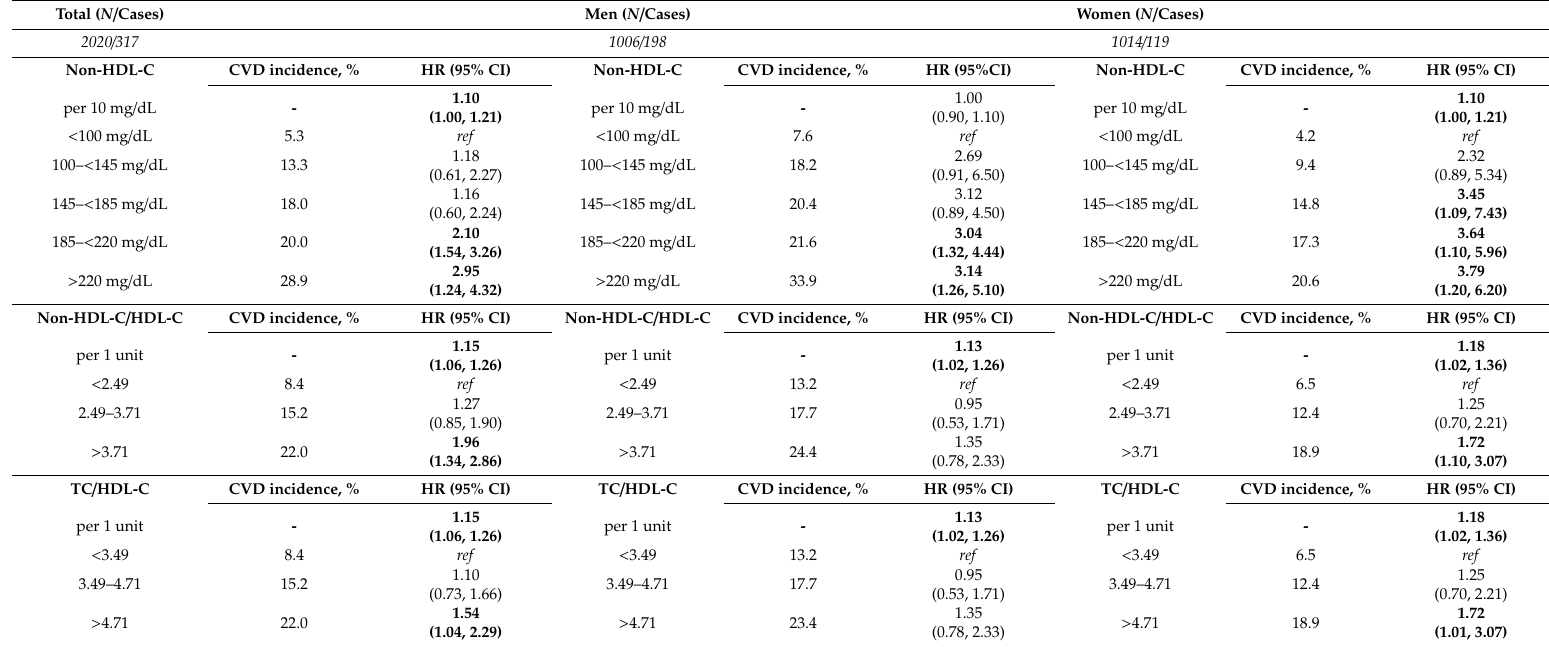
Table 4. Cox regression analysis to evaluate the association between non-conventional lipid markers and 10-year first fatal / non fatal cardiovascular disease incidence in apparently healthy men and women ( n =